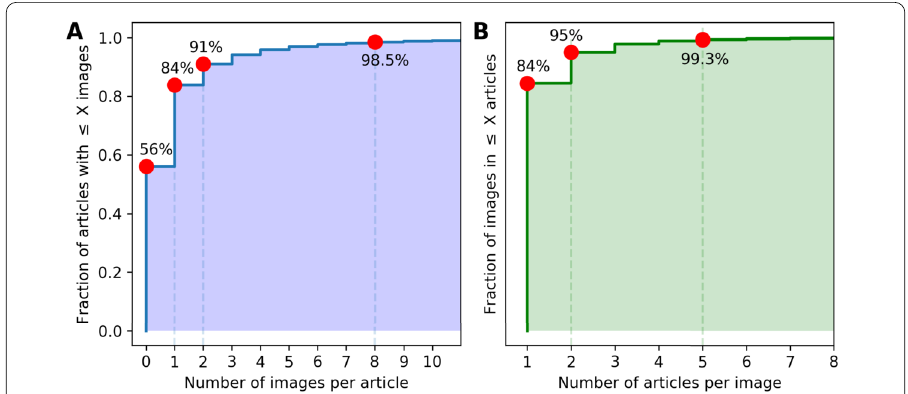
Figure 3 Cumulative distributions of ( A ) number of images per article and ( B ) the number of articles per